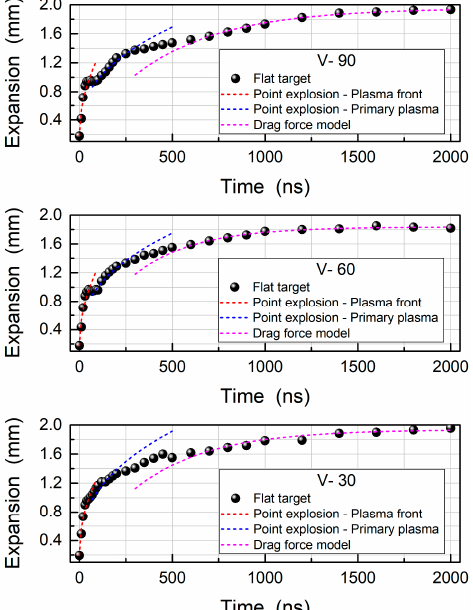
Figure 5. The luminous plume expansion of a laser plasma in air from the 90 ◦ V-channel target ( top row ), the 60 ◦ V-channel target ( middle row ) and the 30 ◦ V-channel target ( bottom row ). Point explosion models were fitted to the plasma front (red curve) and primary plasma (blue curve) for the early delay times while the drag force model (magenta curve) was fitted at late time